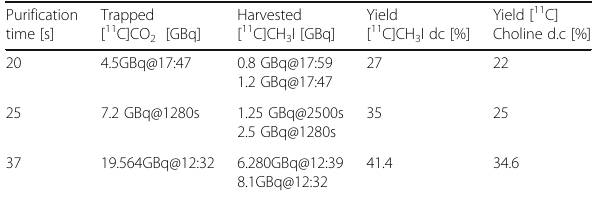
Table 1 (abstract PP50). Results of